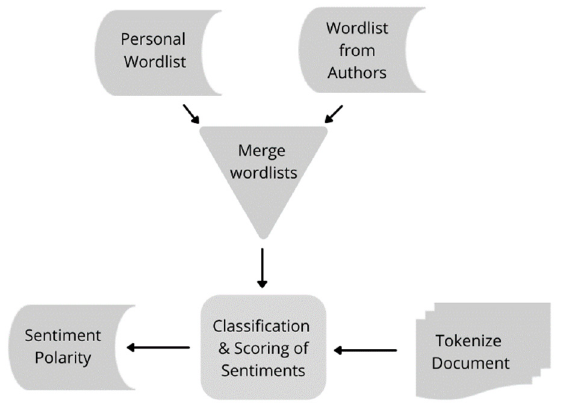
Figure 7. Lexicon-based workflow.